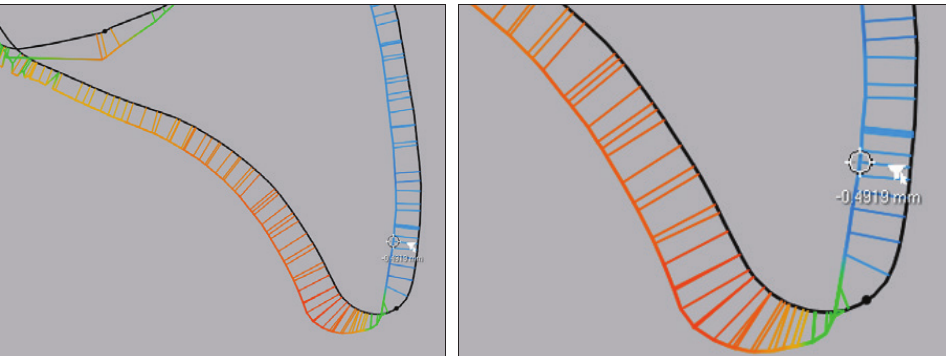
Figure 9. 2D slices can be further measured by clicking on a particular line of displacement, generating, to four decimal points, the displacement of that point from reference to measured